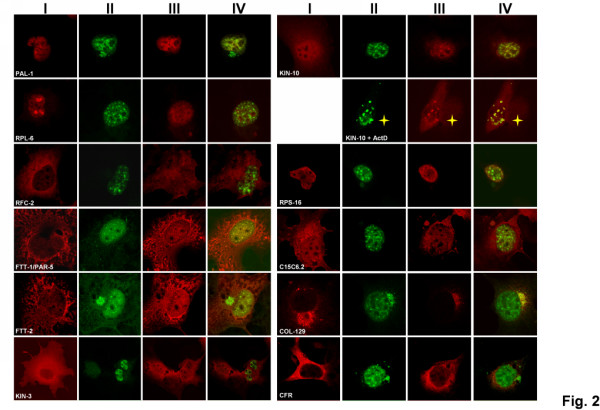
Intracellular localization of LET-756::GFP and HA-tagged protein partners Cos-1 cells were transfected with let-756::gfp with or without various HA-tagged encoded constructs. Twenty four hours later cells were either fixed in 4% paraformaldehyde and permeabilized in triton or in cold methanol. Cells were incubated for an hour with rat anti-HA antibodies. Secondary goat anti-rat Texas red-coupled antibodies were then added for another 30 min. Coverslips were visualized with a confocal Leica microscope. Cells were transfected with the HA-tagged protein alone (column I) or cotransfected with let-756::gfp and revealed by direct fluorescence (column II), by anti-HA immunofluorescence (column III) and merge (column IV). In cells cotransfected with LET-756 and KIN-10 and treated with actinomycin D, both GFP staining and anti-HA immunostaining are displaced around and into the nucleolus. The yellow star indicates a neighbor single KIN-10 transfected cells. Its localization is not modified by the drugs. Panels A and B each show results for five interactors analyzed.